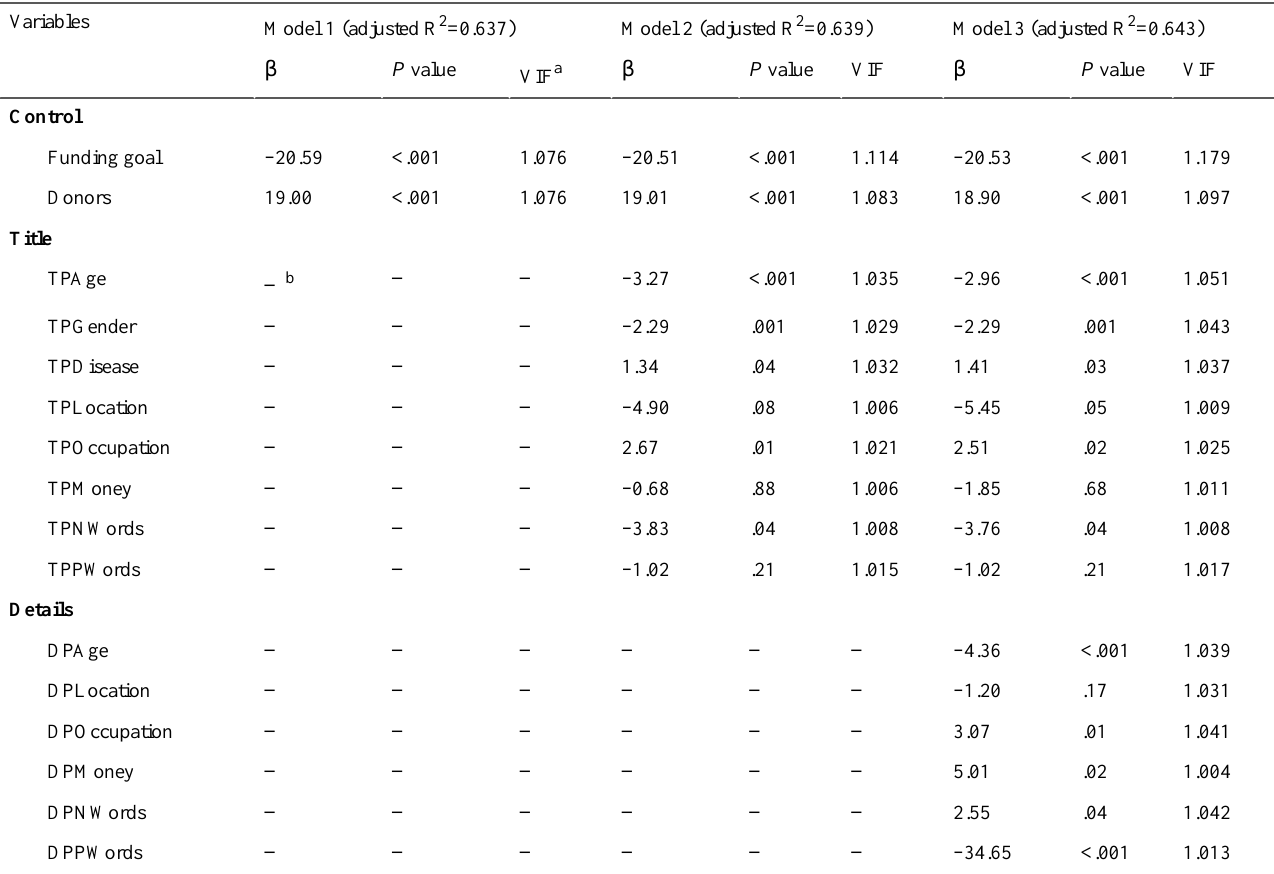
Table 4. Regression results of existence